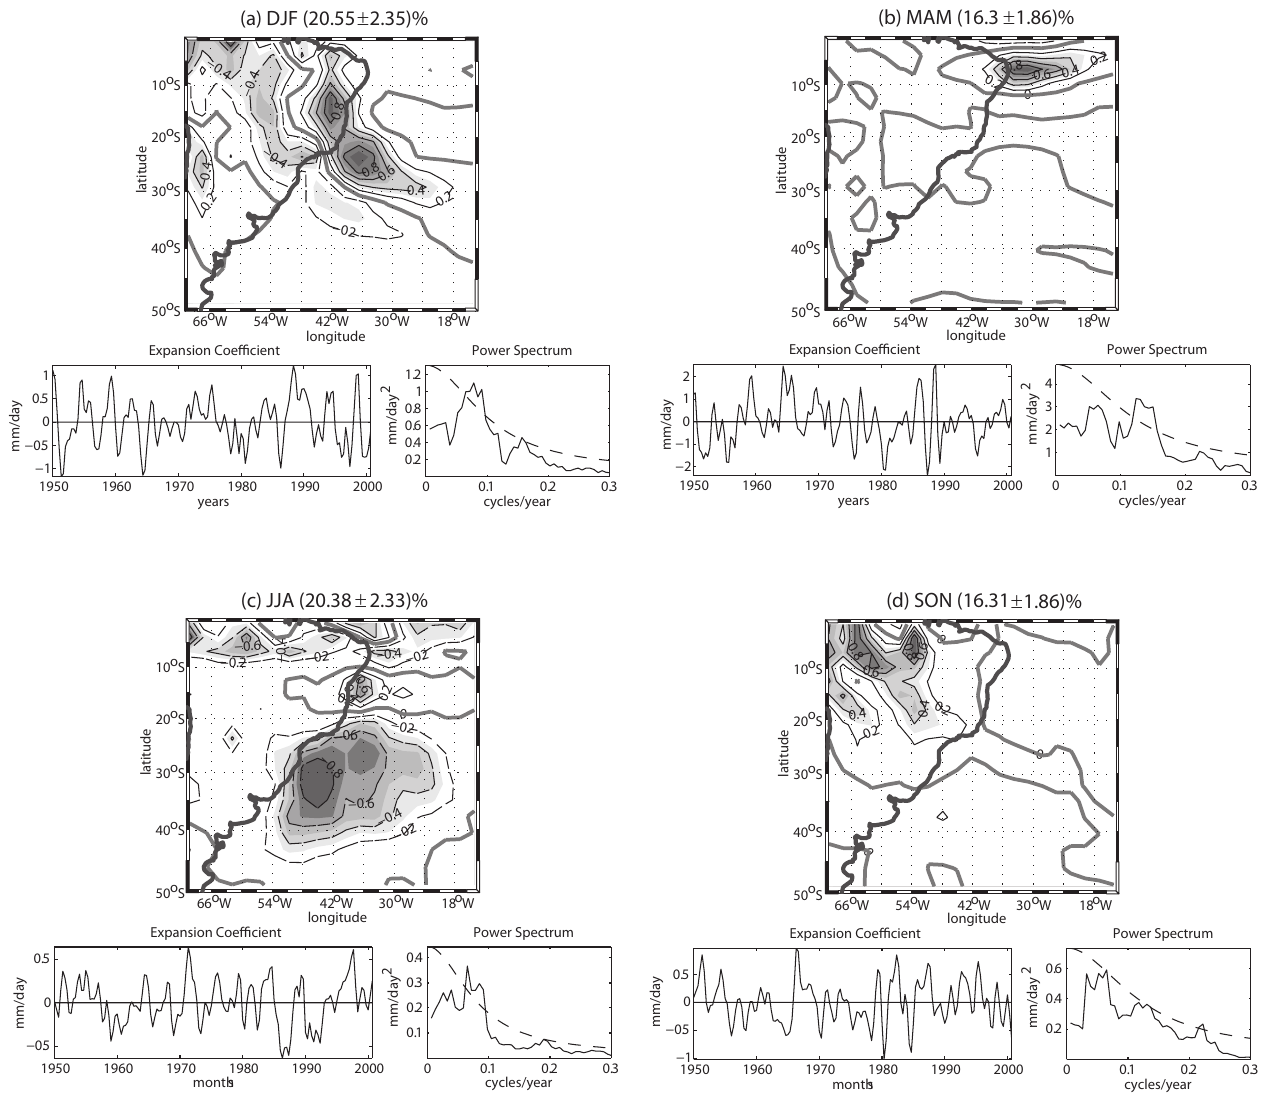
Fig. 6. Second mode of REOF for simulated precipitation from EXP2. Shaded areas represent eigenvector magnitudes higher than | 0.3 | . Time series of expansion coefficients (mmday − 1 ) and the associated power spectrum are located in the panel below. The power spectrum is calculated via multitaper method. Frequencies above the dashed line are significant at the 95% level relative to a red noise background spectrum. (a) DJF, (b) MAM, (c) JJA and (d)